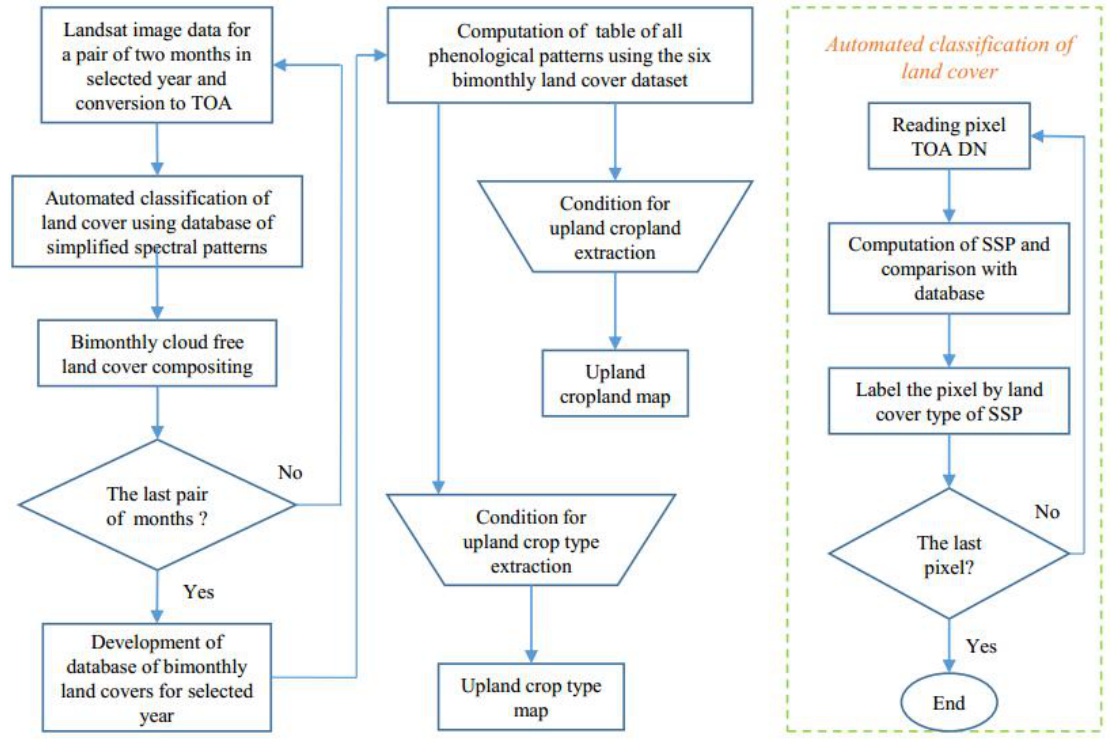
Figure 3. Block diagram of algorithm for cropland and crop type mapping with multitemporal Landsat image data. Procedure for automated classification of land cover is shown in green box in the right